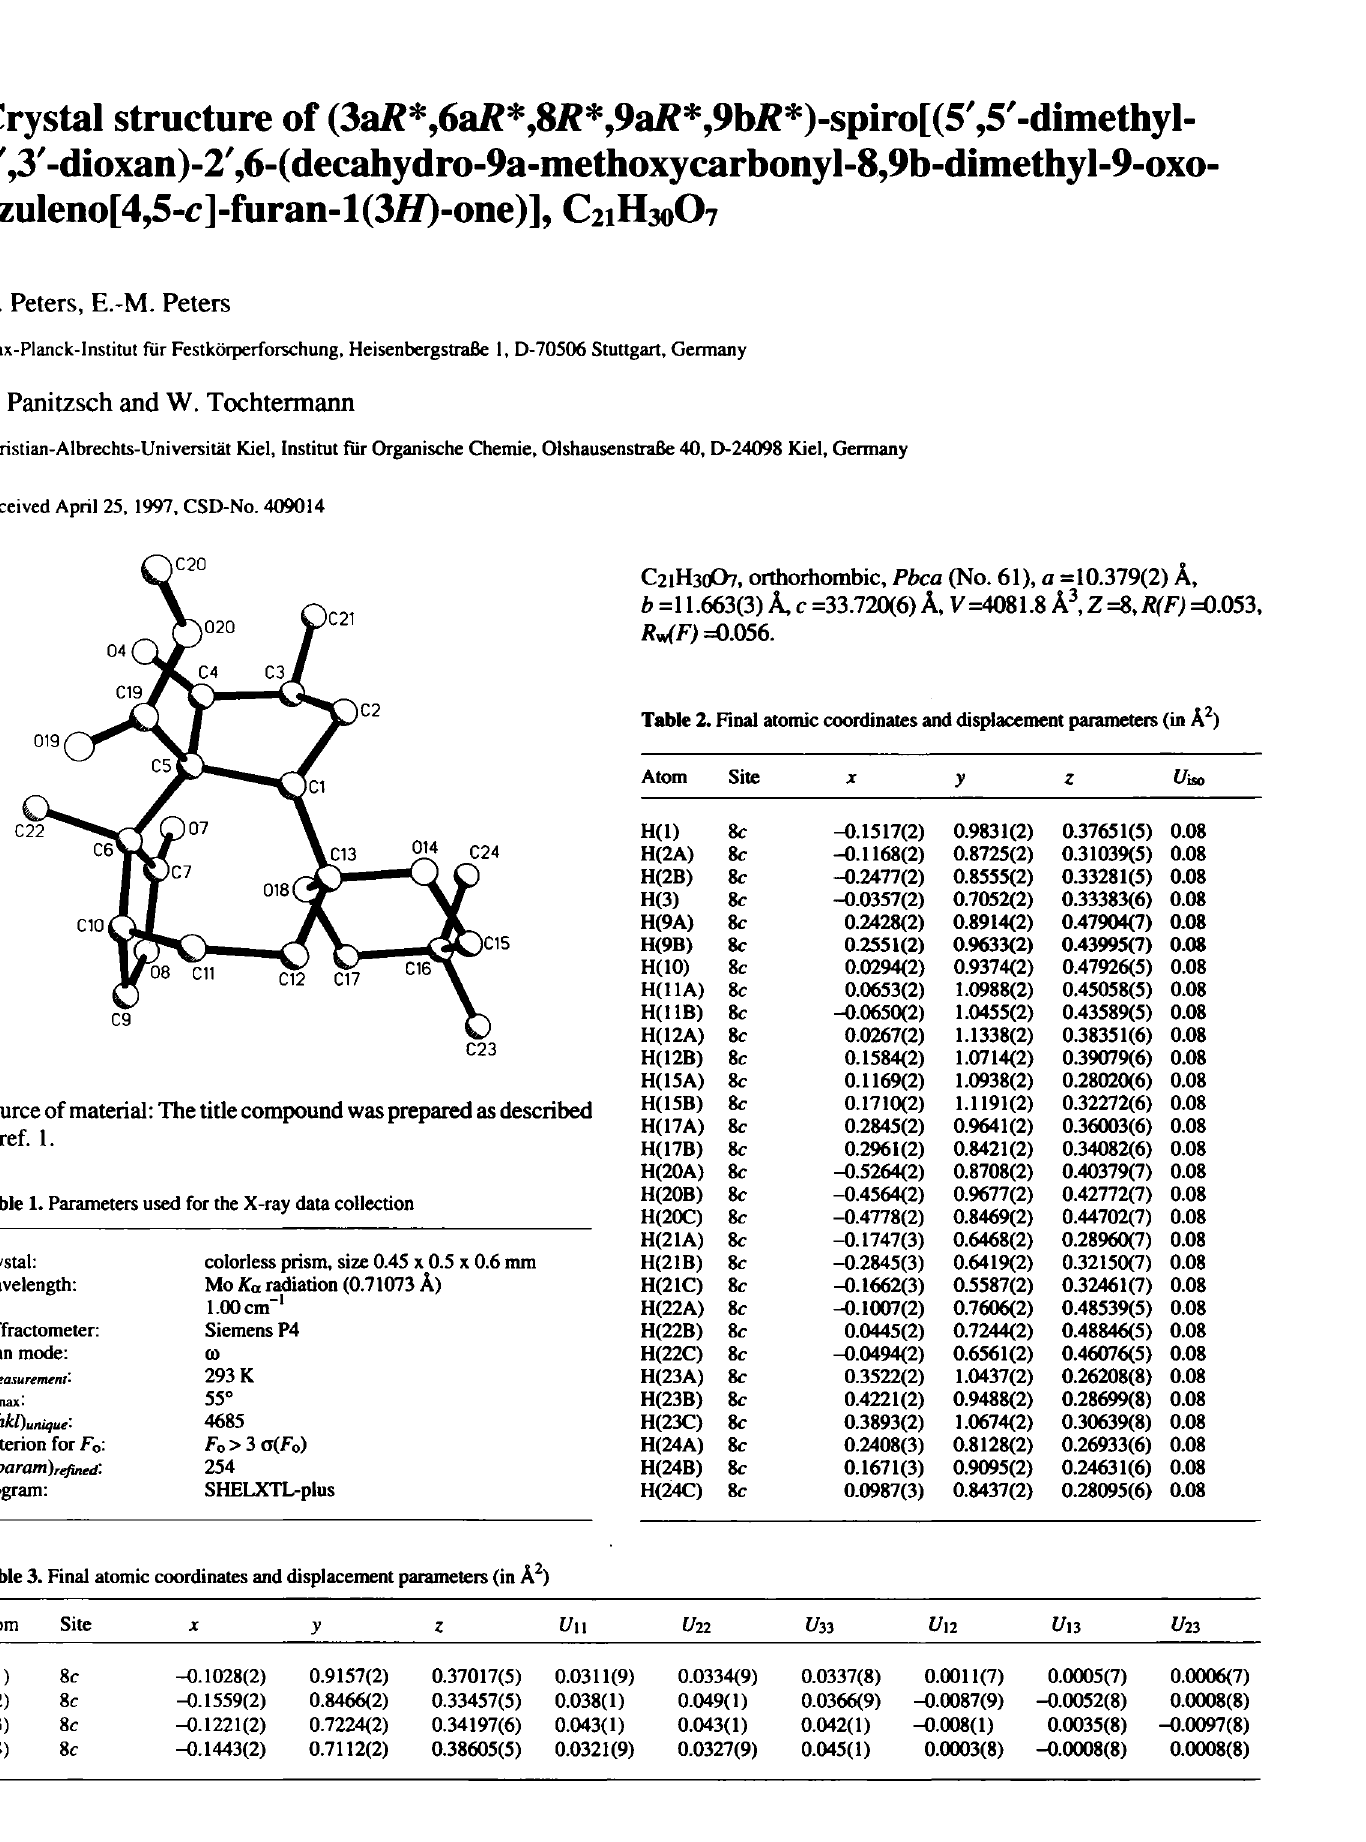
Table 3. Final atomic coordinates and displacement parameters (in Â^)